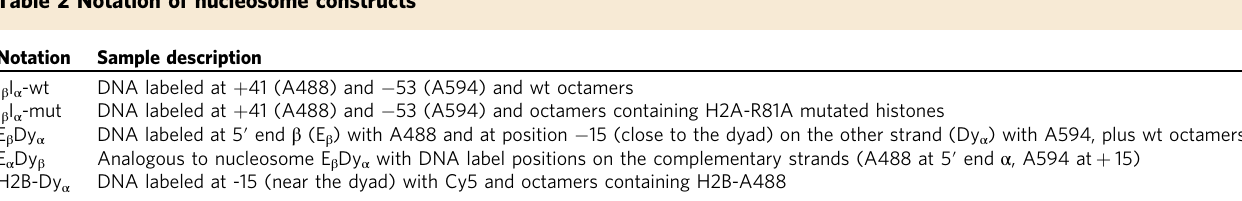
Table 2 Notation of nucleosome